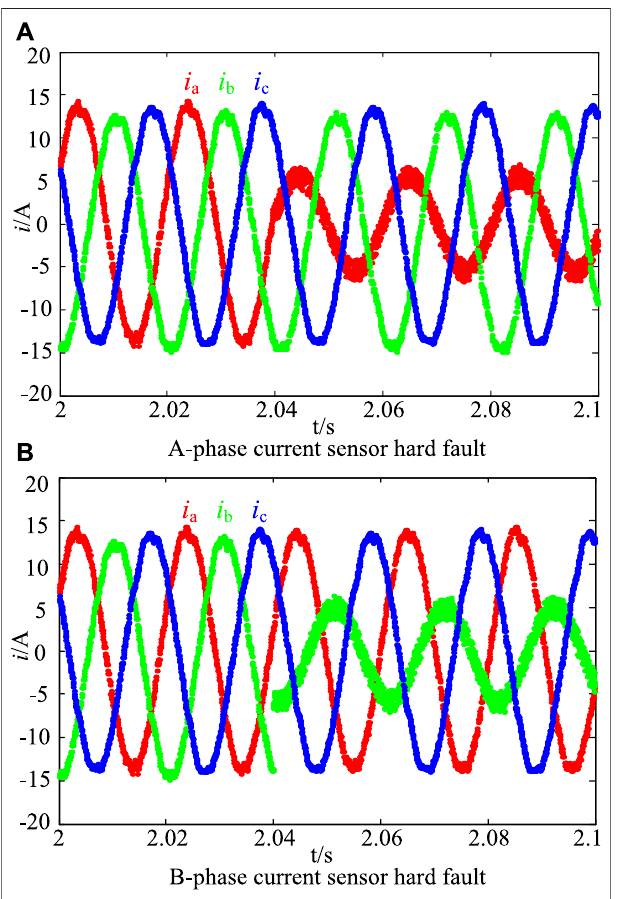
FIGURE 7 | Three-phase current data with current sensor hard fault. FIGURE8|